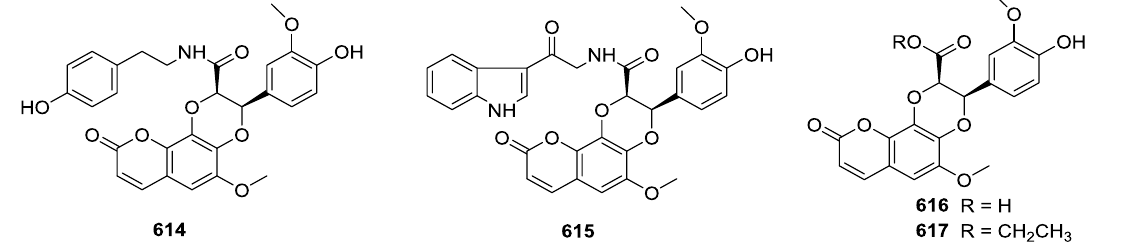
Fig. 14 Coumarinolignoids 614 – 617 from